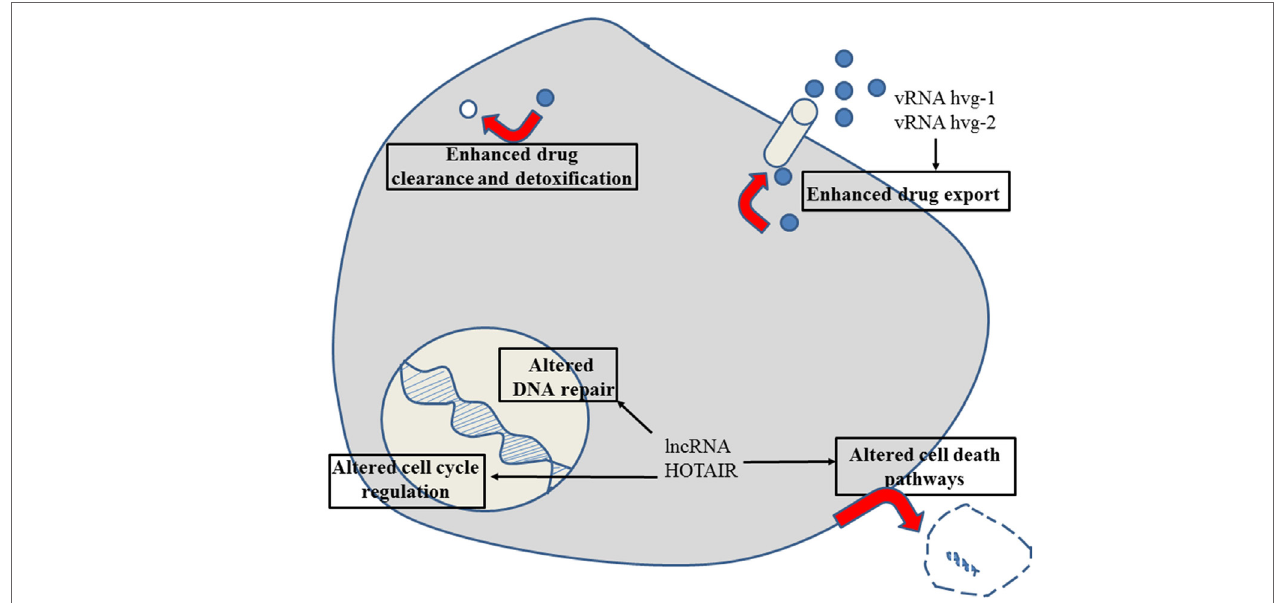
FiGURe 6 | Role of non-coding RNAs for the different reasons that can cause resistance to anticancer drugs in gastrointestinal stromal cancer. For details about target genes and regulated protein expression by the non-coding RNAs, see